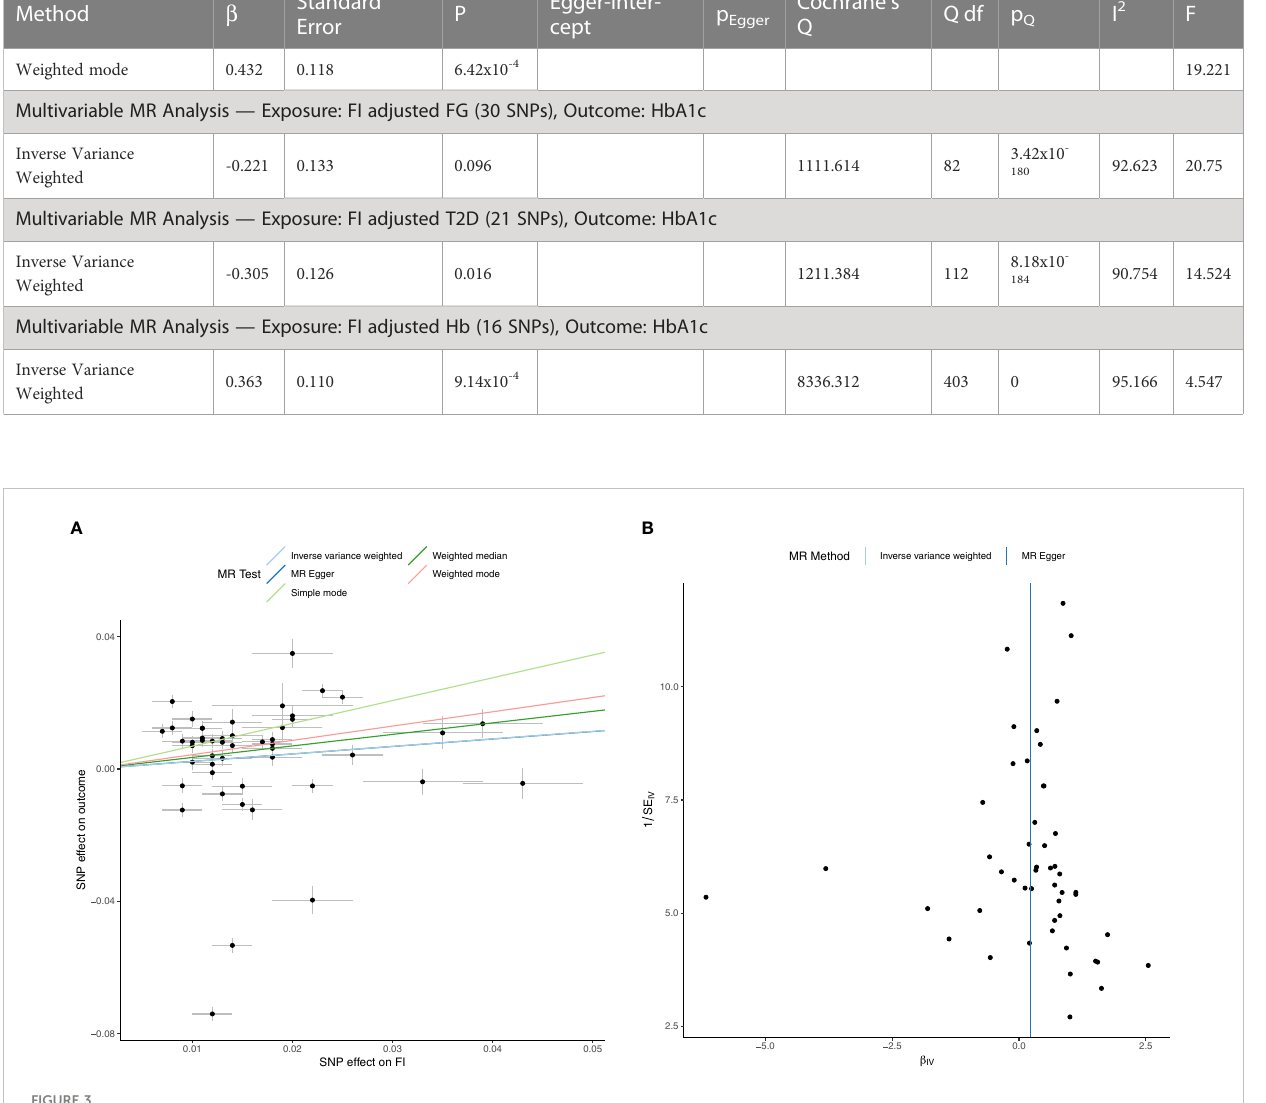
FIGURE 3 Univariable Mendelian Randomization (MR) Analysis — Exposure: fasting insulin (FI), Outcome: HbA1c — (A) Scatter plot showing the single nucleotide polymorphisms (SNPs) associated with FI against SNPs associated with HbA1c (vertical and horizontal black lines around points show 95% con fi dence intervals (CI) for fi ve different Mendelian Randomization (MR) association tests (B) Funnel plot of the effect size against the inverse of the standard error for FI against HbA1c.